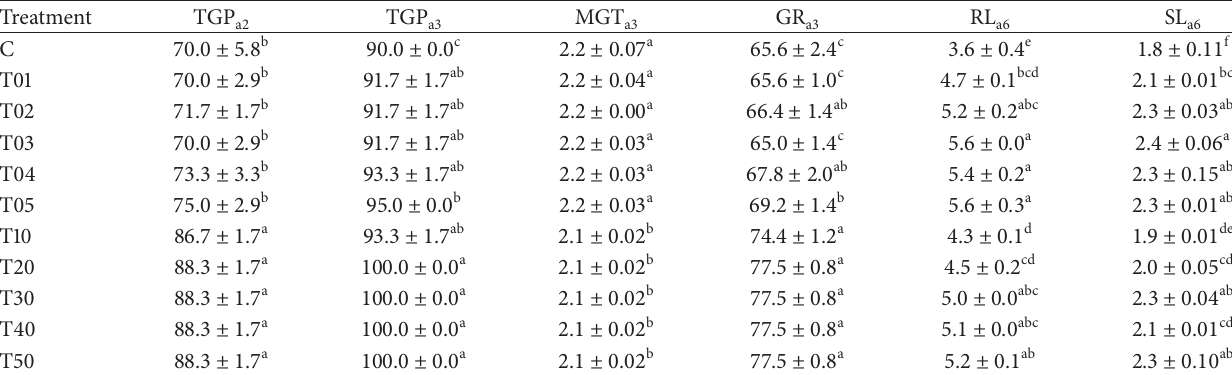
Table 2: The effects of microwave frequency on the studied characteristics in MR 219 rice variety.